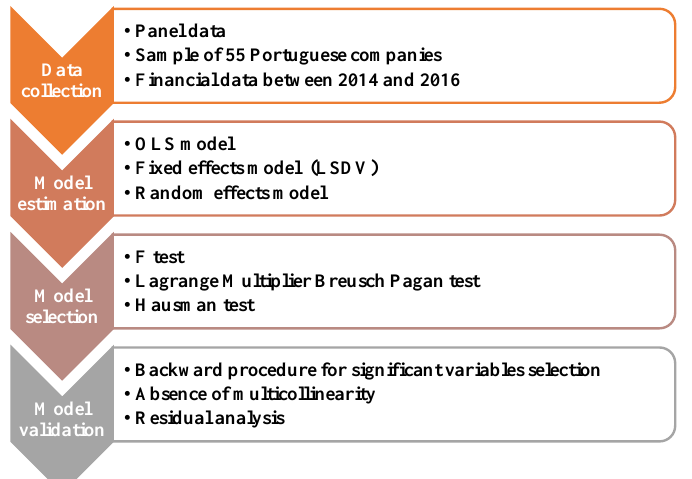
Figure 1. Methodology of the empirical study.